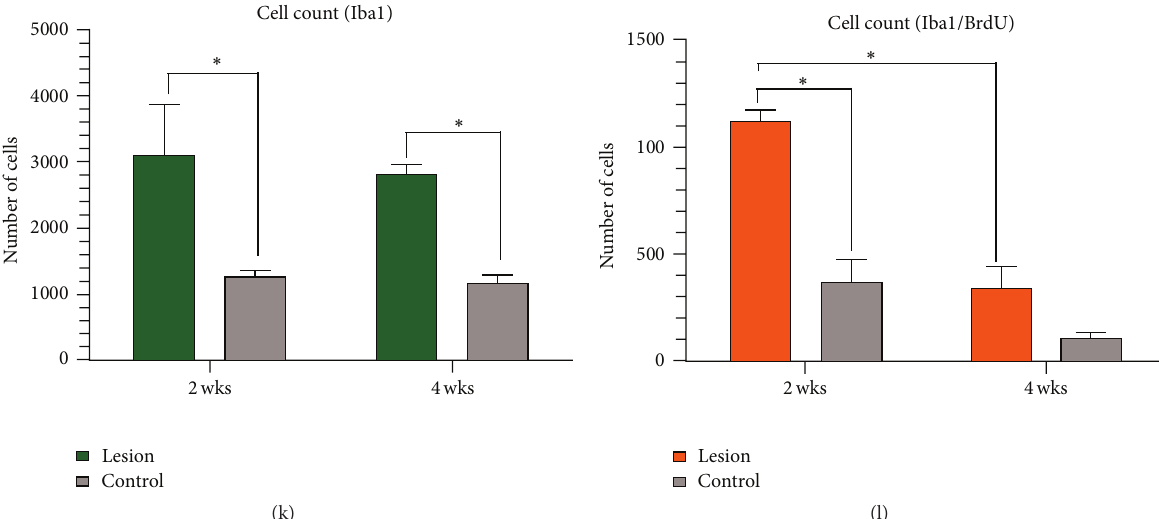
Figure 2: Microgliosis indicated by Iba1 immunostaining in hippocampus at 2wks and 4wks after microlesion. Panels on the left ((a), (c), (e), and (g)) illustrate the microglial response on the unlesioned control side, and the panels on the right ((b), (d), (f), and (h)) are the corresponding lesioned sides. Panels (a), (b) = Iba1 immunostaining; (c), (d) = BrdU+ cells corresponding to sections (a) and (b), respectively. Panels (e), (f) are merged images of Iba1-BrdU signal 2wks after lesion. Panels (g), (h) are merged images of Iba1-BrdU signals 4 wks after lesion. Insert box shows a merged confocal microscopic image of double-labeled Iba-1-BrdU. (i) Microgliosis assessed by image analysis of Iba1 signal. 𝑦 -axis = mean Iba1 signal area (as percent of hippocampal field at 20x magnification). Microglial signal was 16 times greater on the lesioned side than control at 2wks ( ∗ 𝑃 < 0.001 ). The microglial signal on the lesioned side declined significantly after 4 wks ( ∗∗ 𝑃 < 0.001 ) but remained significantly elevated compared to the unlesioned side. (j) BrdU signal area was 3 times greater on the lesioned side at 2wks and declined after 4wks. (k) A number of Iba1+ cells were approximately 2.45 times greater on the lesioned hippocampus compared to the nonlesioned control at both 2 and 4wks ( ∗ 𝑃 < 0.01 ). Notice that microglia in the lesioned hippocampus are larger than on the control side, and therefore, the total Iba1 signal area is much greater than total number of cells. (l) A number of double-labeled microglia (Iba1/BrdU) were also greater on the lesioned side than controls at both 2wks ( ∗ 𝑃 < 0.05 ). Double-labeled microglia comprised ∼ 36% of the total number of Iba1+ cells. Scale bar = 20 𝜇